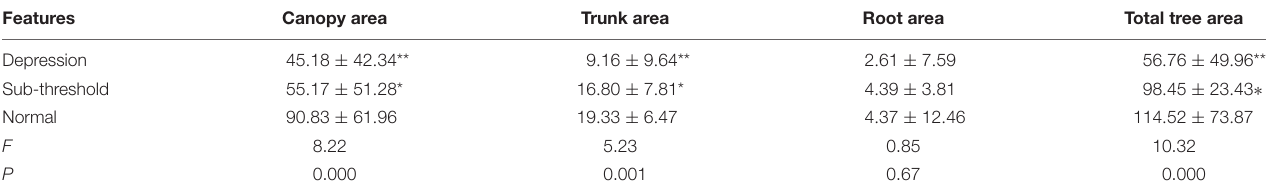
TABLE 1 | Size (cm 2 ) of canopy, trunk, roots, and total tree in the groups.